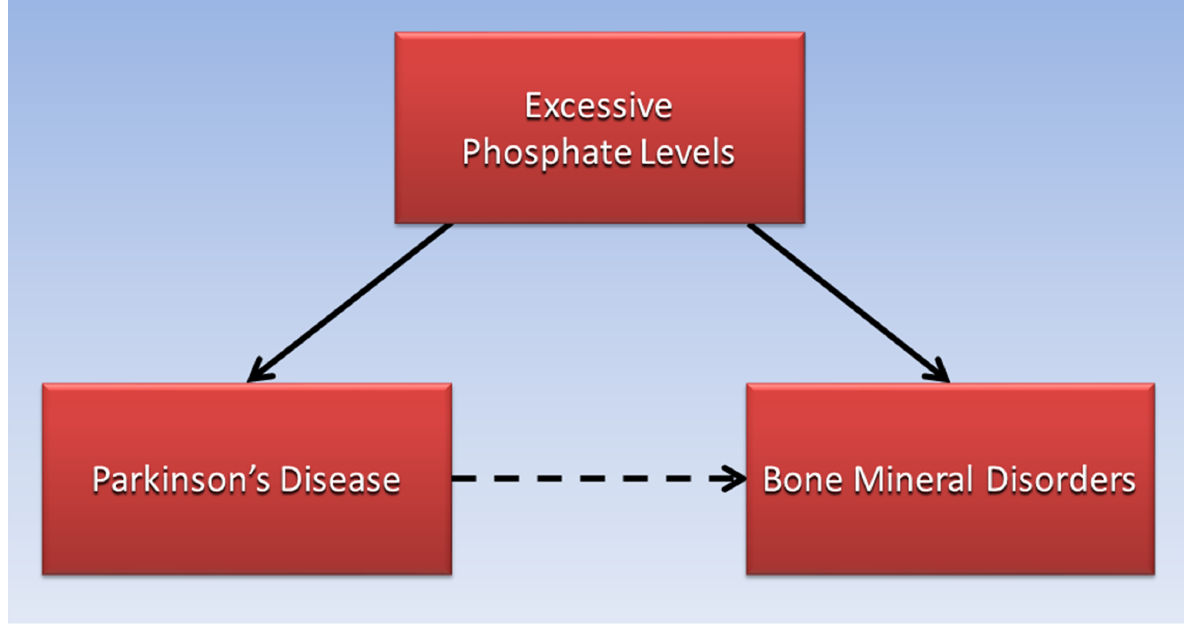
Figure 2. Excessive phosphate levels are proposed to mediate the association of Parkinson’s disease with bone mineral